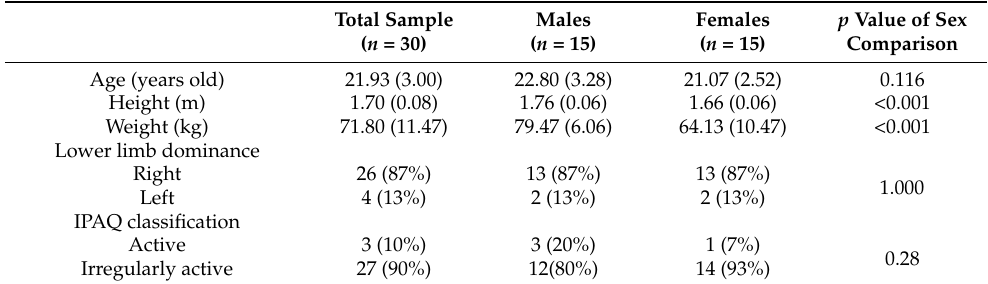
Table 1. Mean and standard deviation of sample characteristics, proportions of lower limb dominance and International Physical Activity Questionnaire (IPAQ)